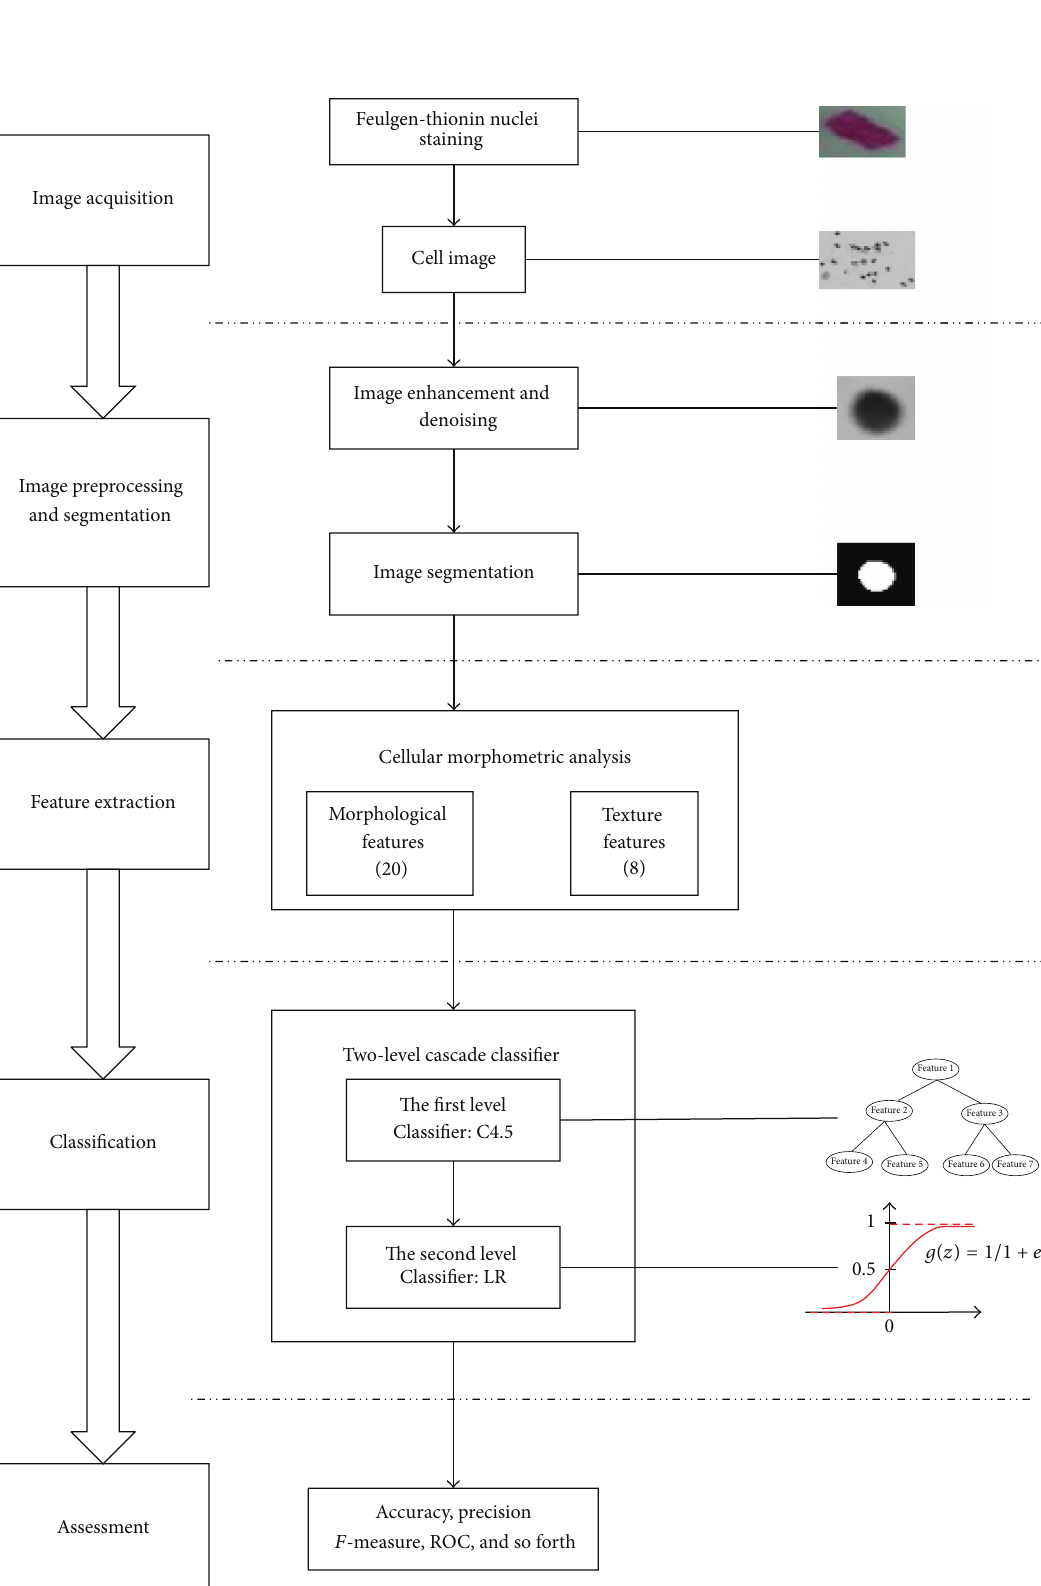
Figure 1: Flowchart of the Automatic Detection